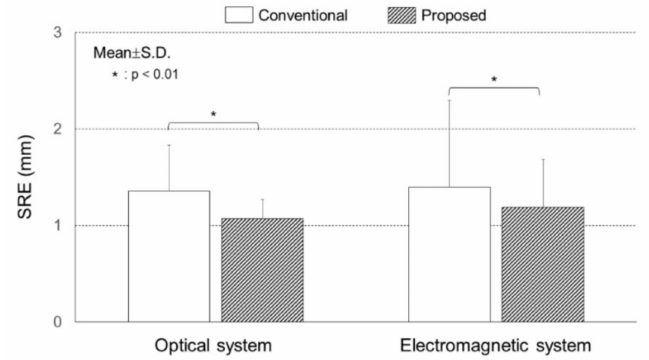
Figure 8. Comparison of SRE between the conventional and proposed registration strategies using the plastic facial